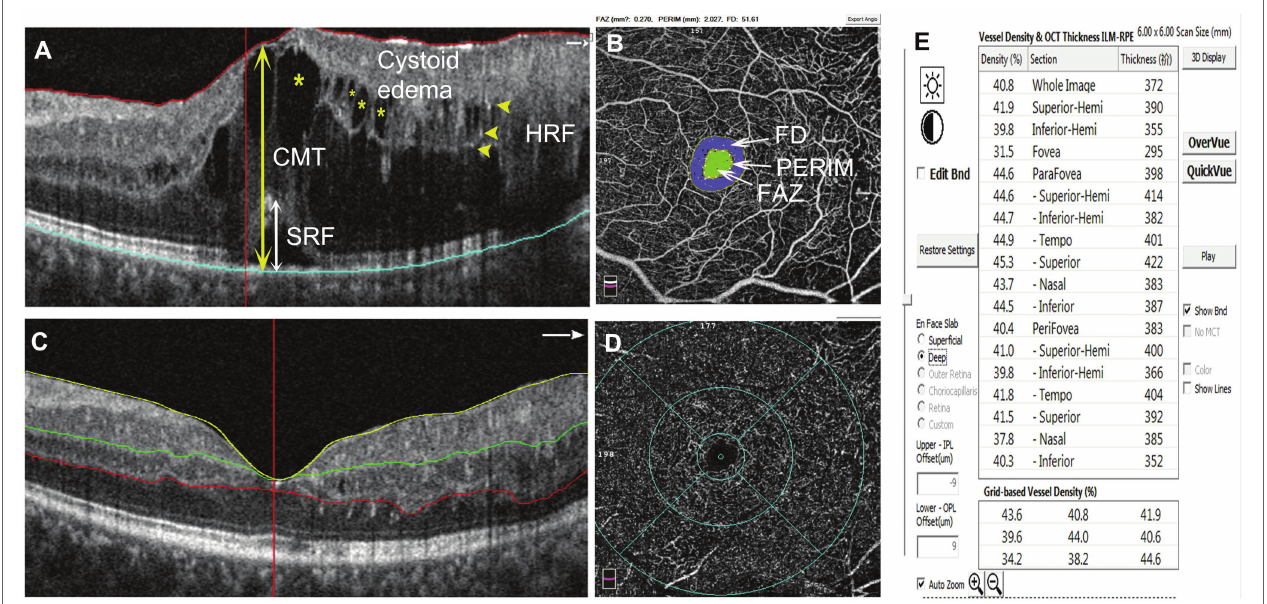
FIGURE 1 | Schematic diagram showing the detected parameters. (A) The measurements of CMT and the height of SRF are indicated with double-head arrows (CMT: yellow, SRF: white). HRF are shown by yellow arrowheads. Cystoid edemas are marked with yellow asterisks. (B) The inner circle (green area) indicates the FAZ area; PERIM is the circumference of the FAZ; FD indicates foveal blood flow density within the blue area. The parameters can be read directly on the image. (C) SCP segmentation was between the ILM (yellow line) and 15 μ m below the IPL (green line). DCP segmentation was between 15 μ m below the IPL (green line) and 70 μ m below the IPL (red line). (D, E) Selecting the density option for the VD parameters of different retinal partitions. CMT, central macular thickness; SRF, subretinal fluid; HRF, hyperreflective foci; FAZ, foveal avascular zone; FD, foveal blood flow density; SCP, superficial capillary plexus; ILM, internal limiting membrane; IPL, inner plexiform layer; and DCP, deep capillary